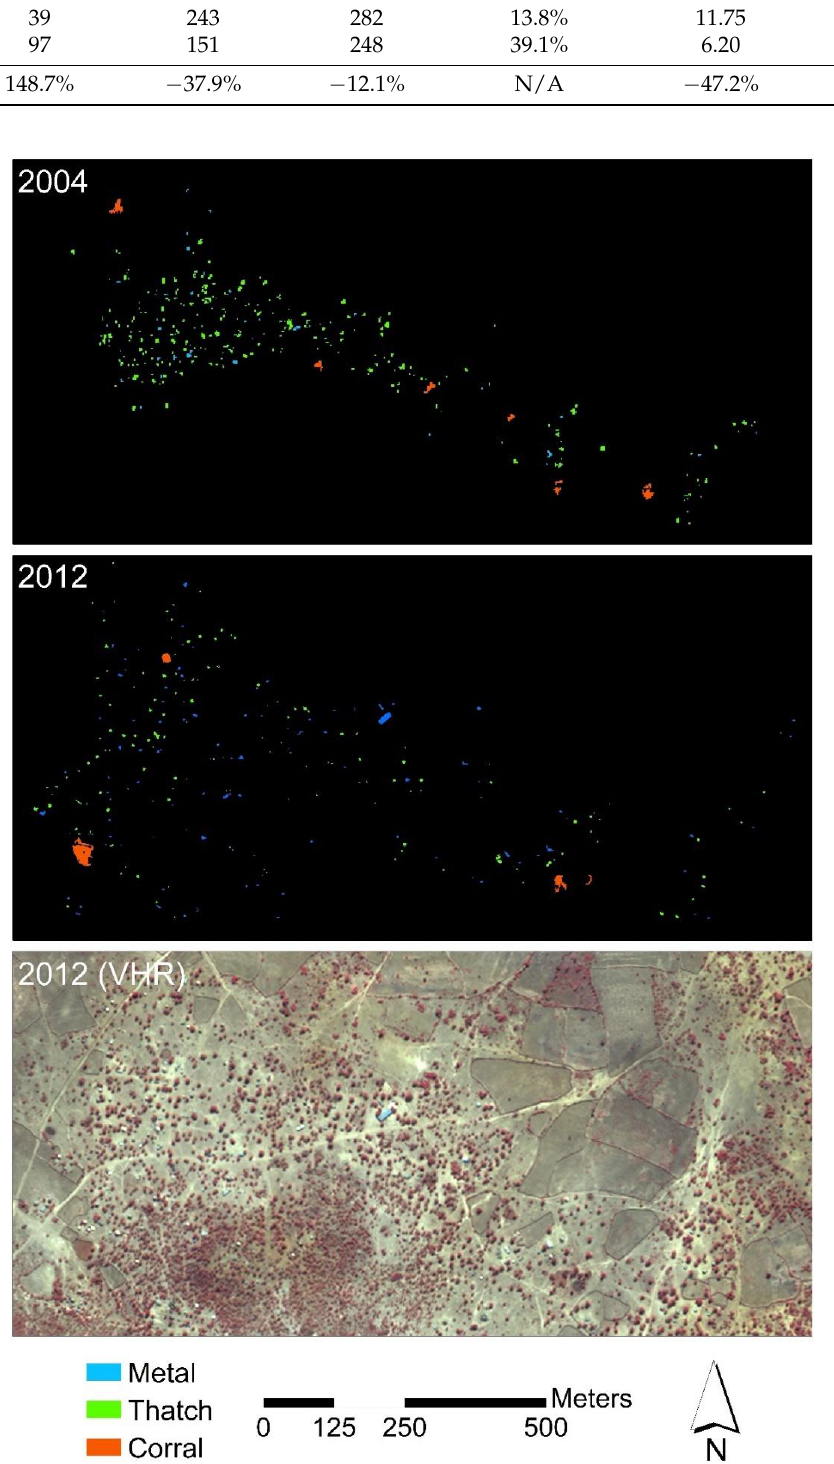
Figure 5. The classification maps ( top : 2004, middle : 2012) for Village 2 based on the 2004 and 2012 VHR images. The bottom panel shows the 2012 VHR image for reference.